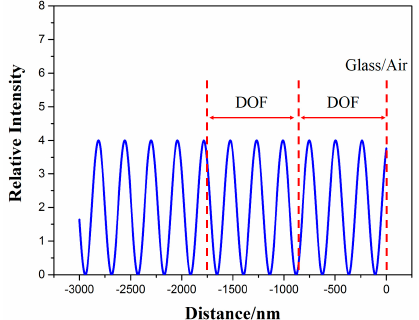
Figure 5. Distribution of the standing wave